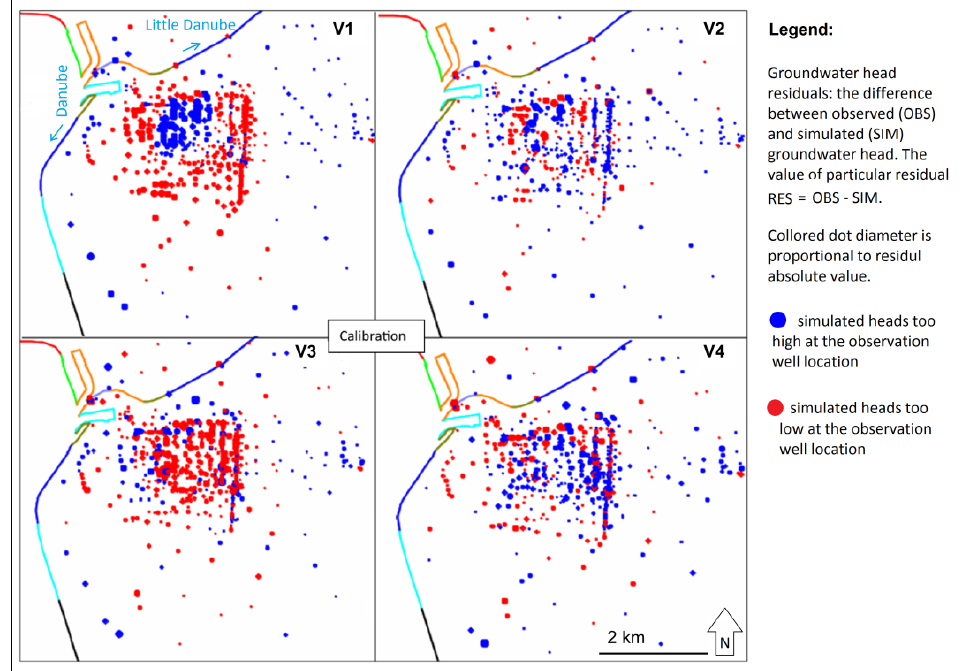
Figure 11. Groundwater head residuals within individual model variants (V1 – V4) after calibration; blue: simulated heads too high, red: simulated heads too low .